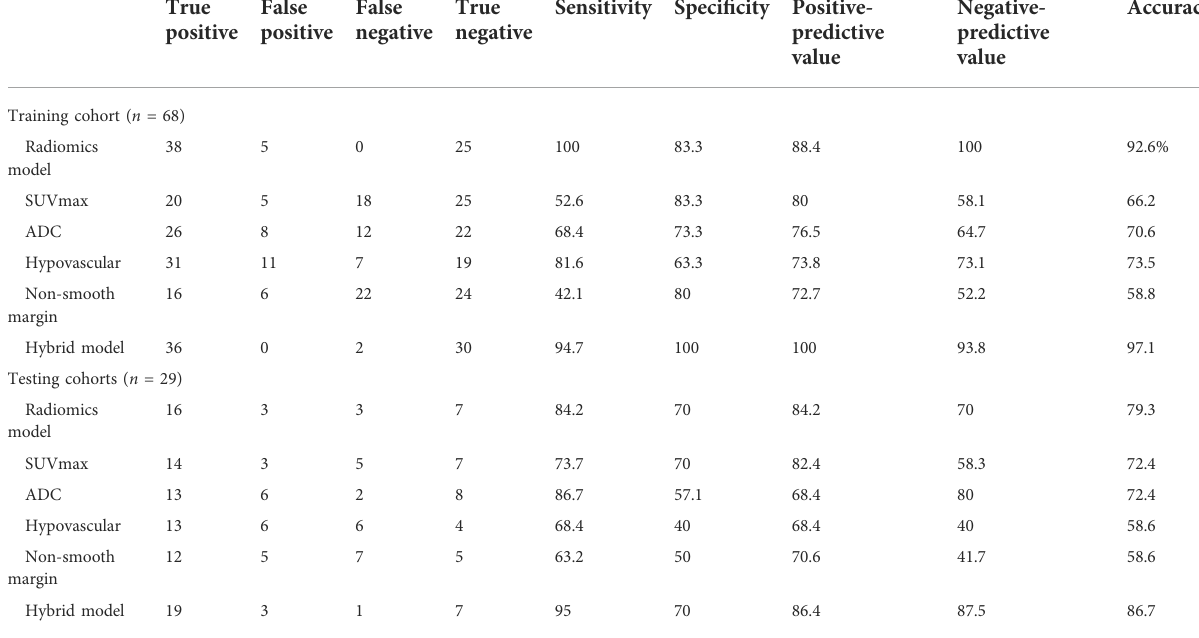
TABLE 4 Diagnostic performance of hepatocellular carcinoma with microvascular invasion in the training and testing